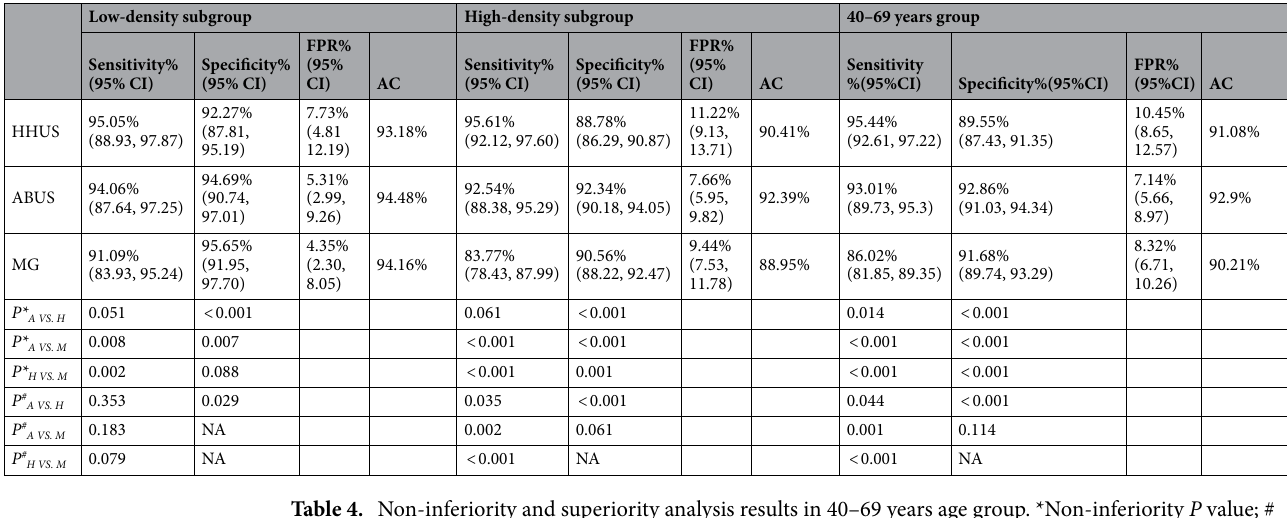
Table 4. Non-inferiority and superiority analysis results in 40–69 years age group. *Non-inferiority P value; # superiority P value; FPR: false positive rate; AUC: area under curve; AC: Accuracy.